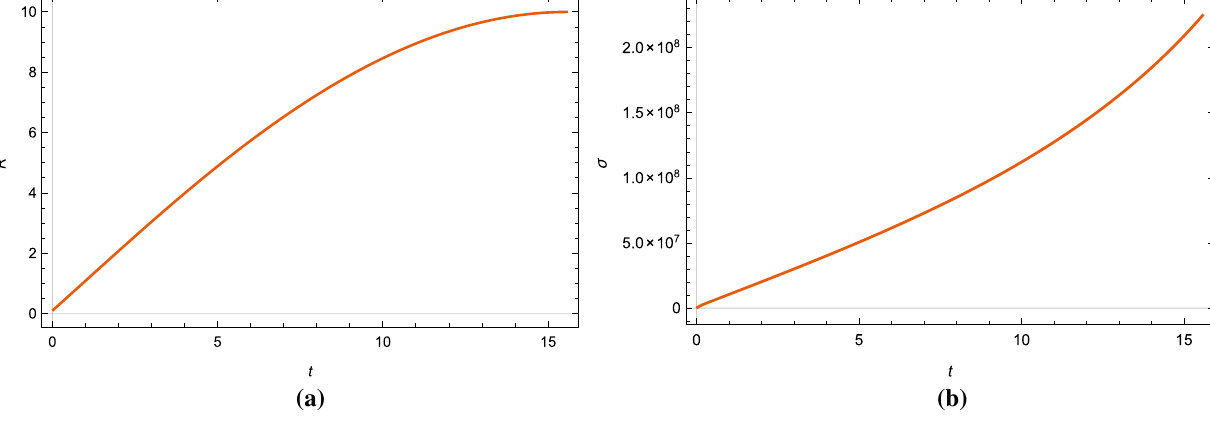
Fig. 7 Evolution of the true vacuum bubble for γ f = 1 . 0. a Radius of the bubble as a function of time t + . b Surface energy density as a function of time t